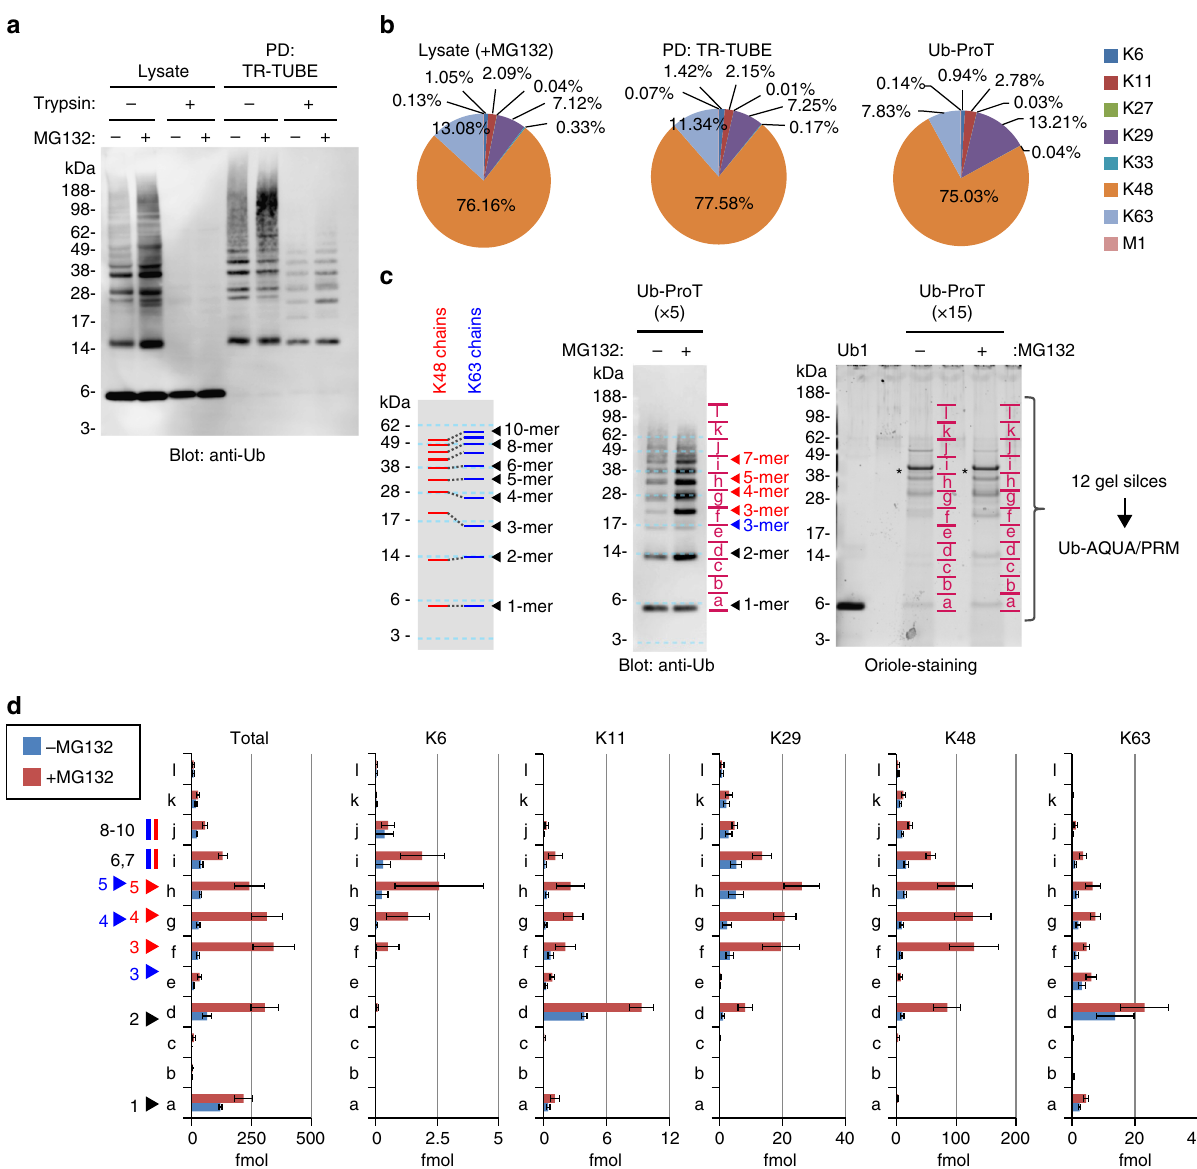
Fig. 3 Length distribution of substrate-attached ubiquitin chains in yeast-soluble lysate. a Ub-ProT analysis of cellular ubiquitylated proteins. Exponentially growing cells were treated with or without 100 μ M MG132 for 4 h. Ubiquitylated proteins in lysates were captured by TR-TUBE and subjected to trypsinization. b Composition of ubiquitin linkages in lysate, TR-TUBE-captured proteins, and Ub-ProT sample. For MG132-treated wild-type cells ( n = 5) and sample pulled down (PD) with TR-TUBE ( n = 4), the gel region above 49 kDa was subjected to Ub-AQUA/MS analysis (Supplementary Data 2). For Ub-ProT samples ( n = 3), sum of Ub linkages quanti fi ed in d was represented (Supplementary Data 3). c Estimation of chain length of Ub-ProT samples. Gel mobility of free K48- and K63-linked chains (left; see Fig. S3 in detail). Anti-ubiquitin blot (middle) and protein staining (right) of the Ub-ProT sample. Here the amount of material analyzed was 5- or 15-fold higher than that in a , for the anti-Ub blot and protein staining, respectively. Gel regions subjected to MS quantitation are indicated by red letters (a – l). The position of the ubiquitin monomer (Ub 1 ) was de fi ned as the gel fraction “ a. ” Asterisks denote TR- TUBE. d Length distributions of total ubiquitin and fi ve major linkages at steady state or following MG132 treatment. Gel fractions in c were analyzed by quantitative mass spectrometry (mean ± s.e.m.; n = 3 biological replicates; Supplementary Data 3). Relative positions of K48- and K63-linked chains are labeled in blue and red,